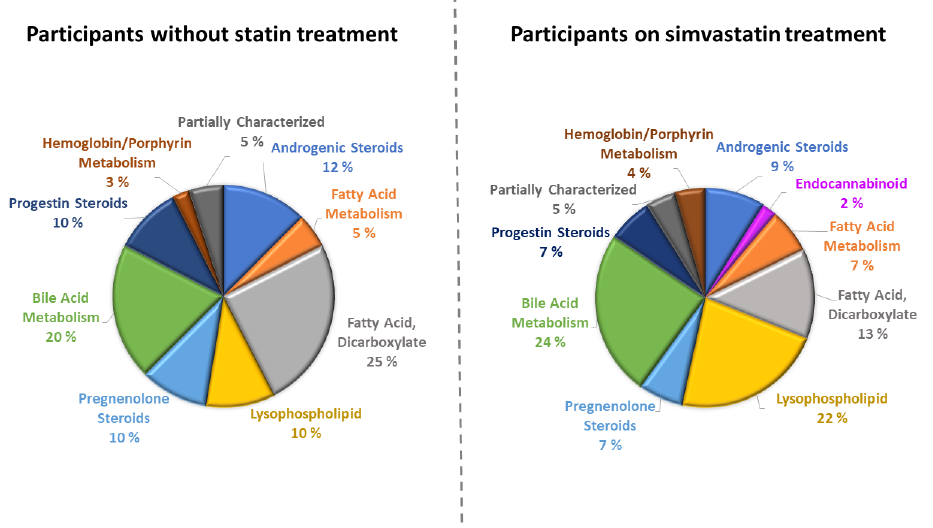
Figure 1. Subclasses of metabolites significantly associated with SLCO1B1 rs4149056-C in participants without statin treatment ( n = 1368) and in participants on simvastatin treatment ( n = 1373).